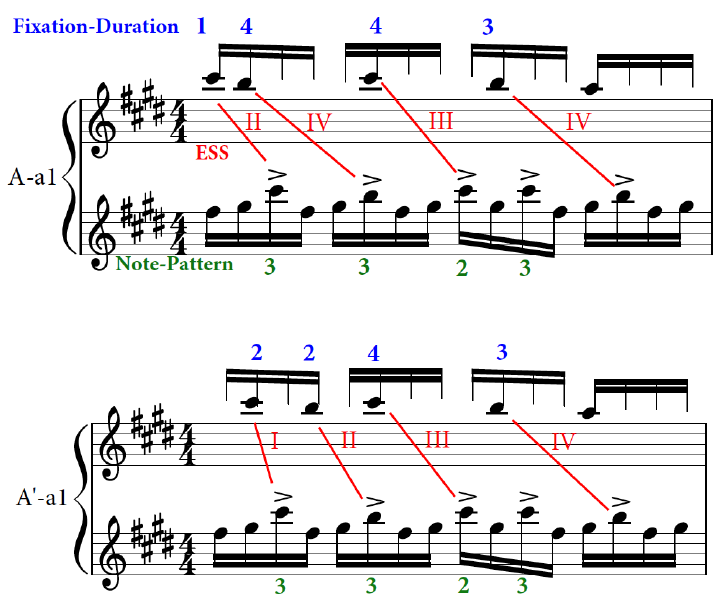
Figure 15. Comparison of the relationship between Fixation-Duration, Eye-Stroke Span and Note-Pattern in two identical musical passages of the musical excerpt of ‘Porgy and Bess’ for Player #2 (127bpm). The Note-Pattern segmentation remains identical while the Fixation-Duration and ESS